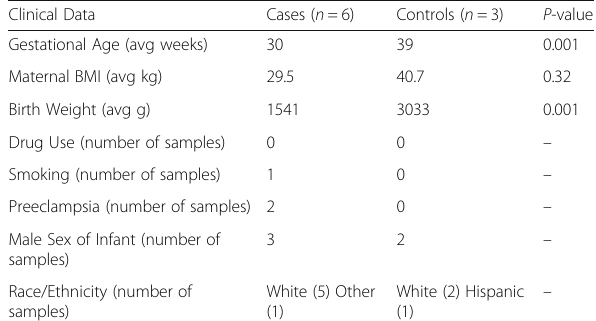
Table 1 Summary of Clinical characteristics of sampled patients Clinical Data